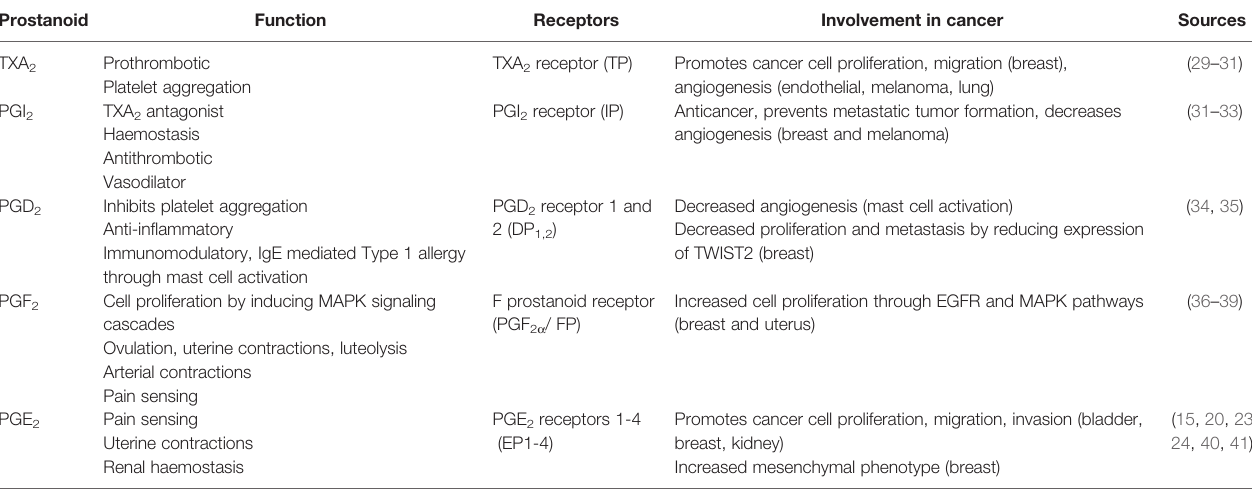
TABLE 1 | Summary of the function of the prostanoid products, their receptors, and role in cancer.